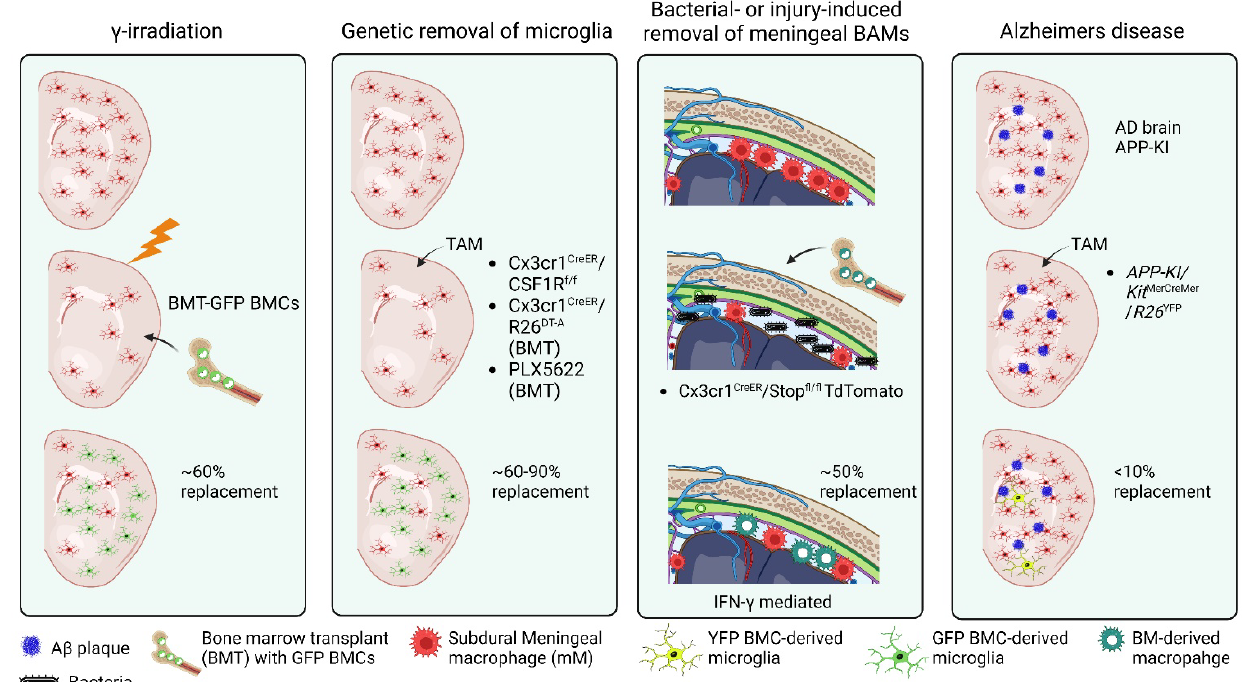
Figure 2. Peripheral-derived monocytes replace microglia and BAMs under defined experimental conditions, infection, and Alzheimer’s disease. Panel 1: gamma irradiation-induced replacement; Panel 2: genetic or pharmacological methods to delete microglia induces replacement by peripheral cells; Panel 3: Bacterial infection or brain injury loss of border-associated macrophages (BAMs) induces replacement by peripheral cells; Panel 4: Alzheimer’s disease induces minimal replacement of microglia by peripheral myeloid cells. BMT = bone marrow transplant; AD = Alzheimer’s disease; TAM = tamoxifen; BMCs = bone marrow cells; YFP = yellow fluorescent protein; GFP = green fluorescent protein.